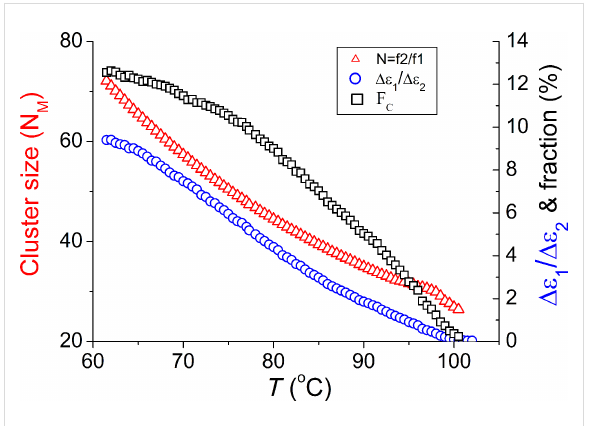
Figure 3: Temperature dependent cluster size (i.e., an average num- ber of molecules involved in a cluster) (open red triangles), ratio of the dielectric strength, Δε 1 / Δε 2 (open blue cirecles), the volume fraction of clusters (open black squares) in the bulk nematic phase, F C